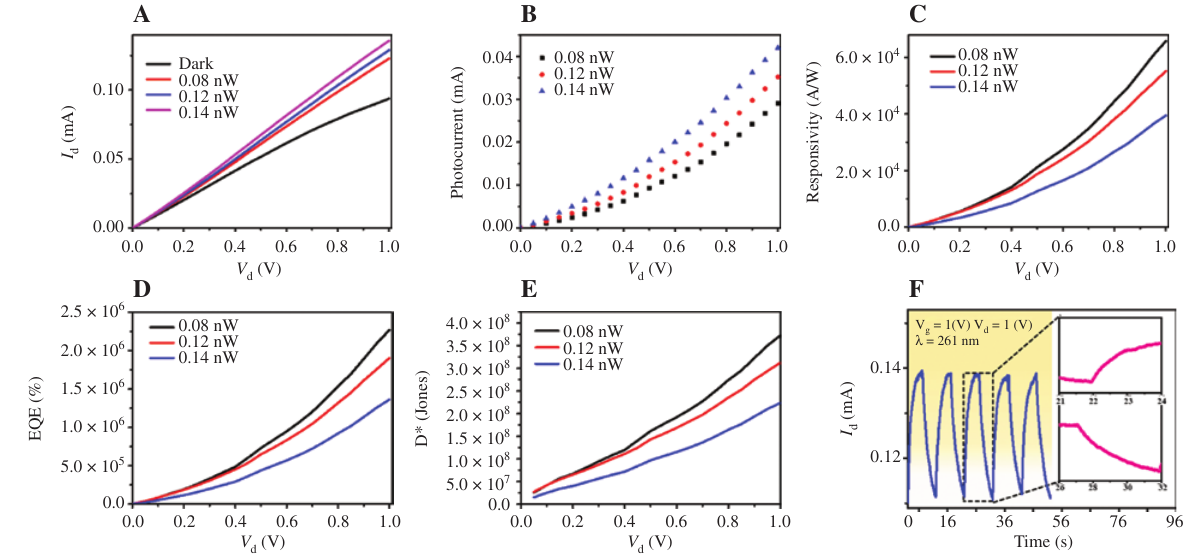
Figure 3: Optoelectronic characterization of the Te NS photodetector by illumination at 261 nm. (A) I - V curves of the Te NS photodetector obtained in dark and with illumination at various excitation intensities (0.08 nW, 0.12 nW, and ds ds = 3 V. (B) I 0.14 nW) at V - V curves of the Te NS photodetectors for different excitation powers with illuminations of 0.08 nW, 0.12 nW, and g p ds = 3 V). (C) Responsivity of the Te NS photodetector vs. light illumination power. 0.14 nW, which exhibit a linear dependence on the bias ( V g (D) EQE of Te NS photodetector vs. light illumination power. (E) D * of the Te NS photodetector vs. light illumination power. (F) I - t response = 1 V. Inset: dynamic response of the Te NS photodetector during on/off of the curve under an illumination of 261 nm, P = 0.14 nW, and V ds incident light with a temporal